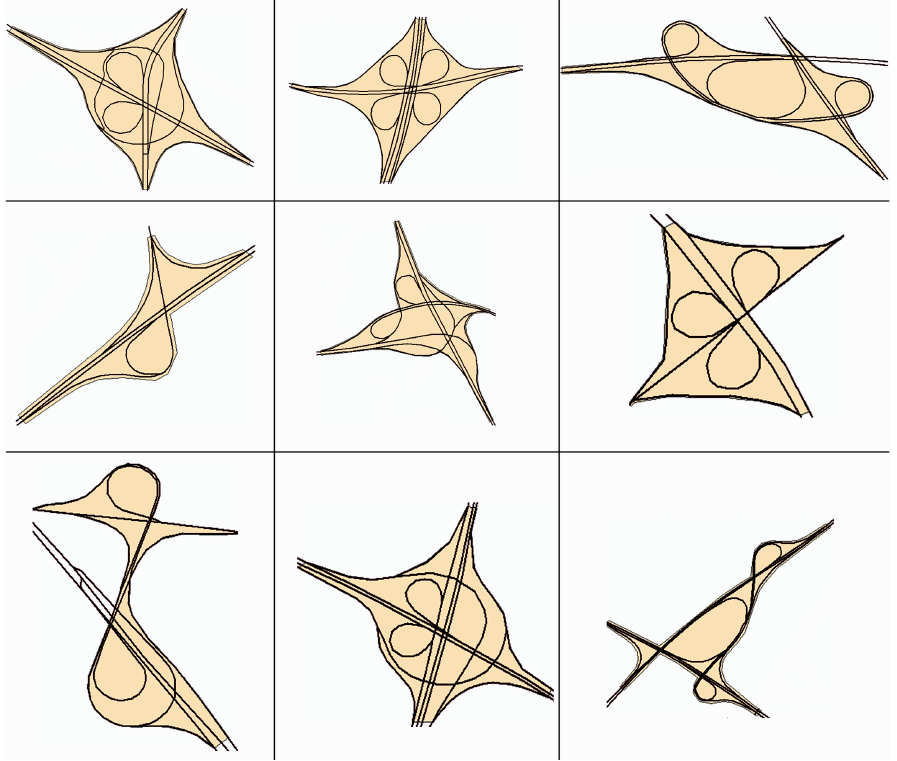
Figure 4. The labelled overpass data.